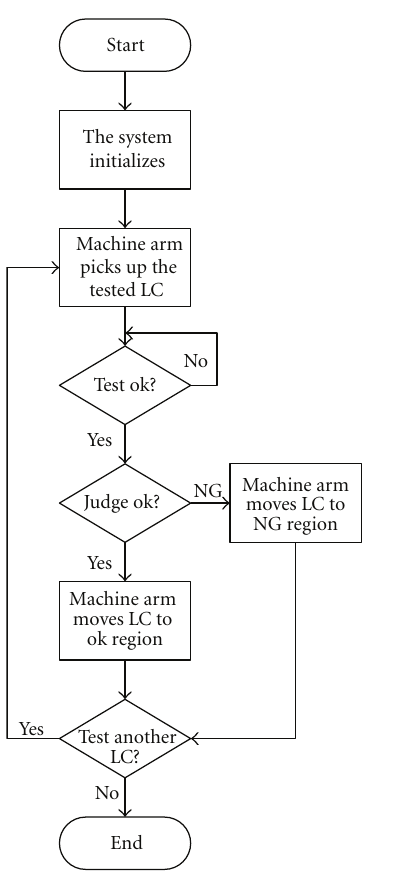
Figure 8: The flow chart of the control program.